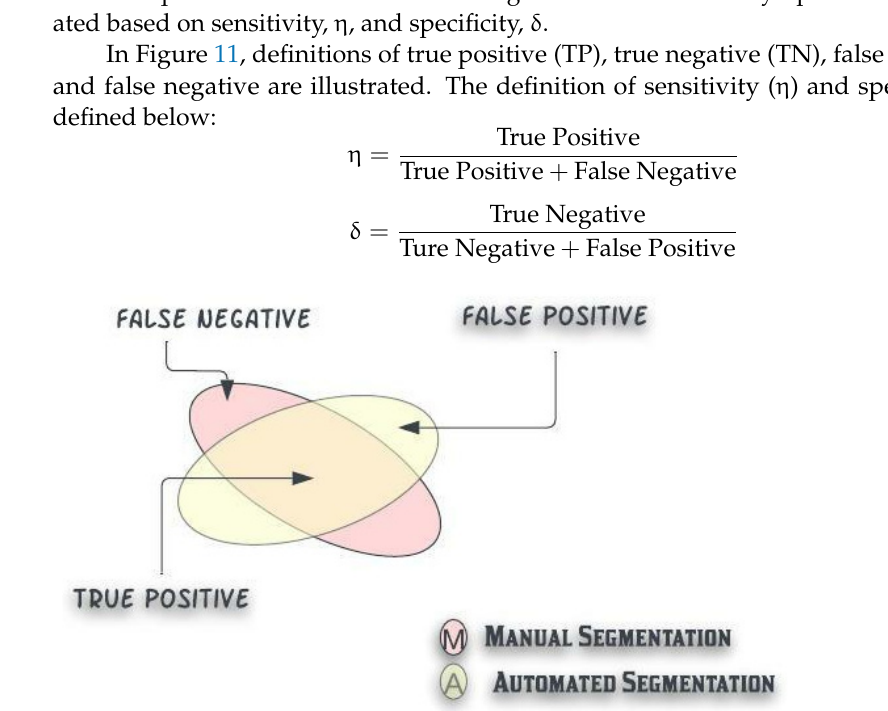
Table 4. Analysis of CB detection based on the proposed detection algorithm.